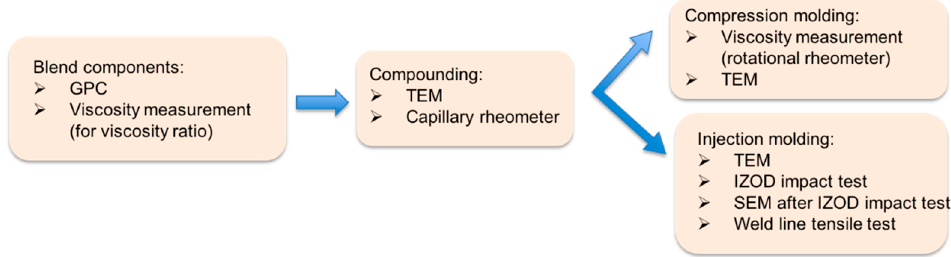
Figure 2. Processing scheme of this study.